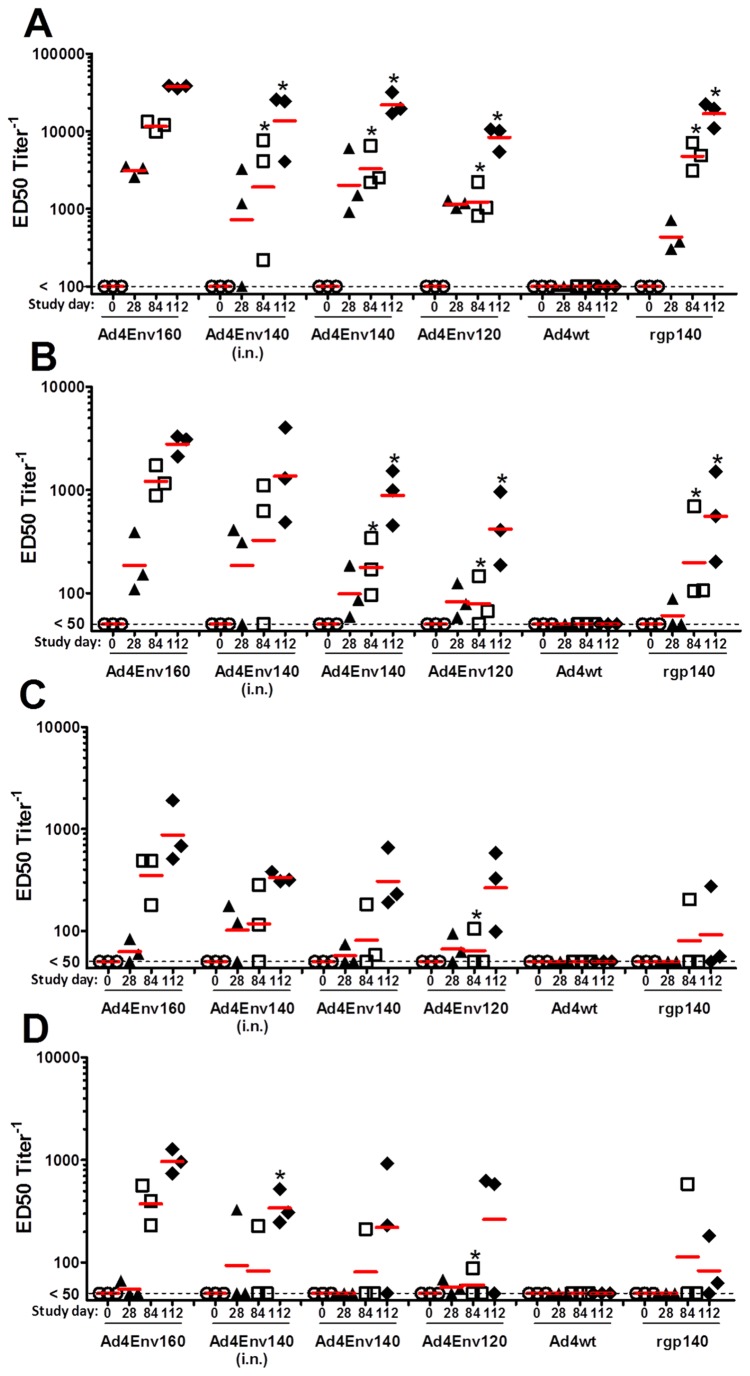
Immunogenicity of Ad4Env160, Ad4Env140, and Ad4Env120 recombinant viruses in rabbits.Three rabbits per group were immunized on days 0 and 28 with each of the Ad4Env 1086 clade C recombinant vectors and booster immunizations were performed on day 84 with recombinant Env 1086 clade C 140 glycoprotein. Ad4Env vectors were administered by the i.m route with the exception of one group which also received the Ad4Env140 vector by the i.n. route. Positive control rabbits were immunized three times with the recombinant Env 1086 clade C gp140 in Rehydragel on days 0, 28 and 84. Negative control rabbits were immunized three times with Ad4wt virus, i.m., on days 0, 28 and 84; antibody titers were all <50 for this group. Serum samples were collected on days 0 (pre-vaccine), 28, 84 and 112. The ELISA coating antigens were: (A) Env 1086 clade C 140 glycoprotein; (B) Env140 1086 clade C V1V2 polypeptide; (C) Env A244 AE strain V1V2 polypeptide; and (D) clade B Env CASE A V1V2 scaffold fusion protein. For each of the ELISA antigens, statistical analysis using the t-test was performed comparing antibody titers induced by the Ad4Env160 vector versus titers induced by each of the other Ad4Env vectors or by the Env140 1086 clade C glycoprotein. Groups with a statistical difference (p ≤ 0.05) in geomean ED50 antibody titers relative to Ad4Env160 vector immunogen are denoted by an asterisk.